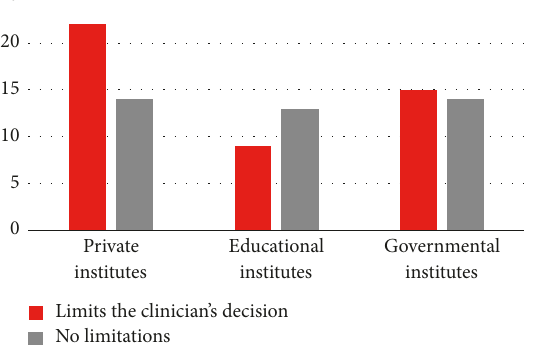
Figure 5: Role of the laboratory production.